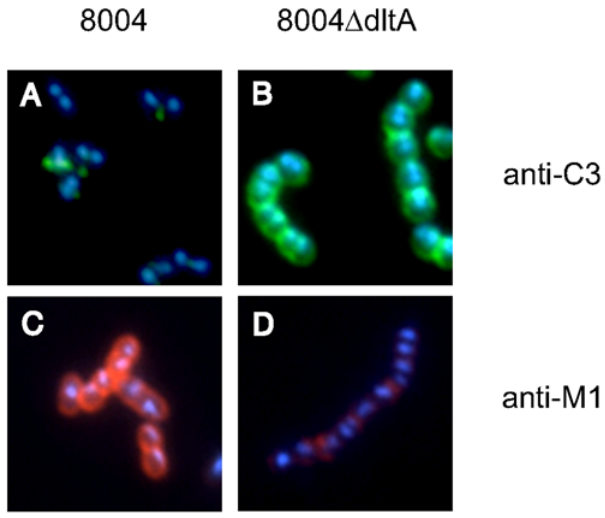
Figure 5. Localization of C3 and M1 by immunofluorescence. WT 8004 cells (Panels A and C) and 8004 D dltA cells (Panels B and D) were stained either with human anti-C3 (Panels A and B) or anti-M1 (Panels C and D) antibodies. DAPI staining (blue) was used to visualize nuclei. Note that the fluorescence associated with M proteins (red) decreases in the dltA mutant and the fluorescence associated with C3 dramatically increases (green).